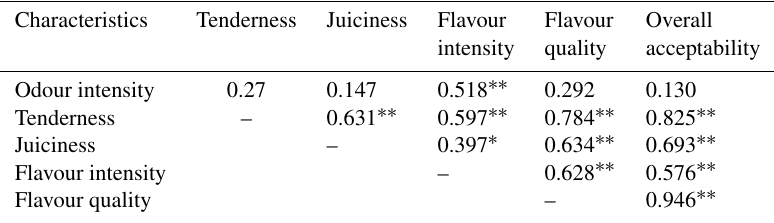
Table 7. Coefficient of correlation among for meat sensory characteristics.